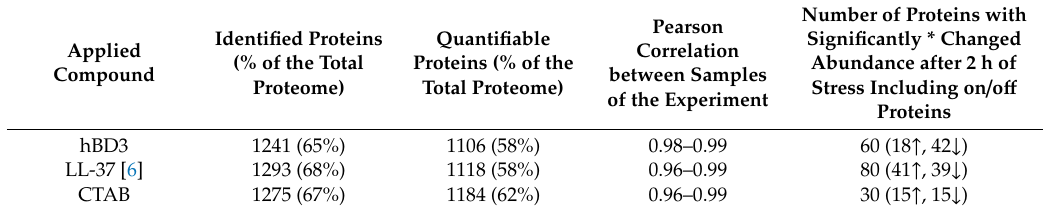
Table 1. Summary of proteomic analyses. Arrows indicate the number of proteins that were statistically more or less abundant after two hours of stressor application in comparison to the experiment’s control condition. On / o ff proteins are included. * Student’s t -test ( p -value = 0.01, min. fold change = 1.5). On / o ff proteins are proteins which were exclusively identified in either stress or control samples. Data for LL-37 treatment were obtained from [6]. n = 4 (hBD3), n = 6 (LL-37) [6], n = 3 (CTAB). Number of Proteins with Pearson Significantly * Quantifiable Identified Proteins Correlation Applied Proteins (% of the (% of the Total between Samples Compound Total Proteome) Proteome) of the Experiment